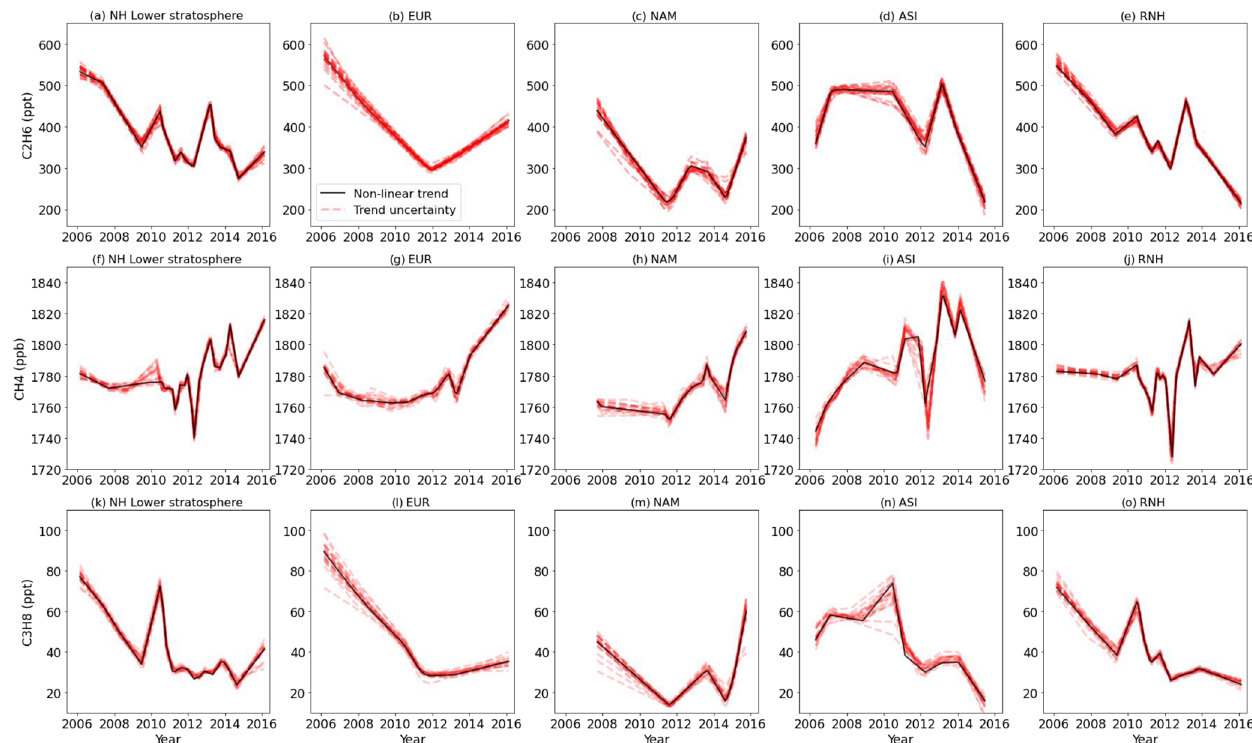
Figure 6. Nonlinear trends of the lower stratospheric ethane, methane and propane over five regions (whole NH lower stratosphere, EUR, NAM, ASI, and